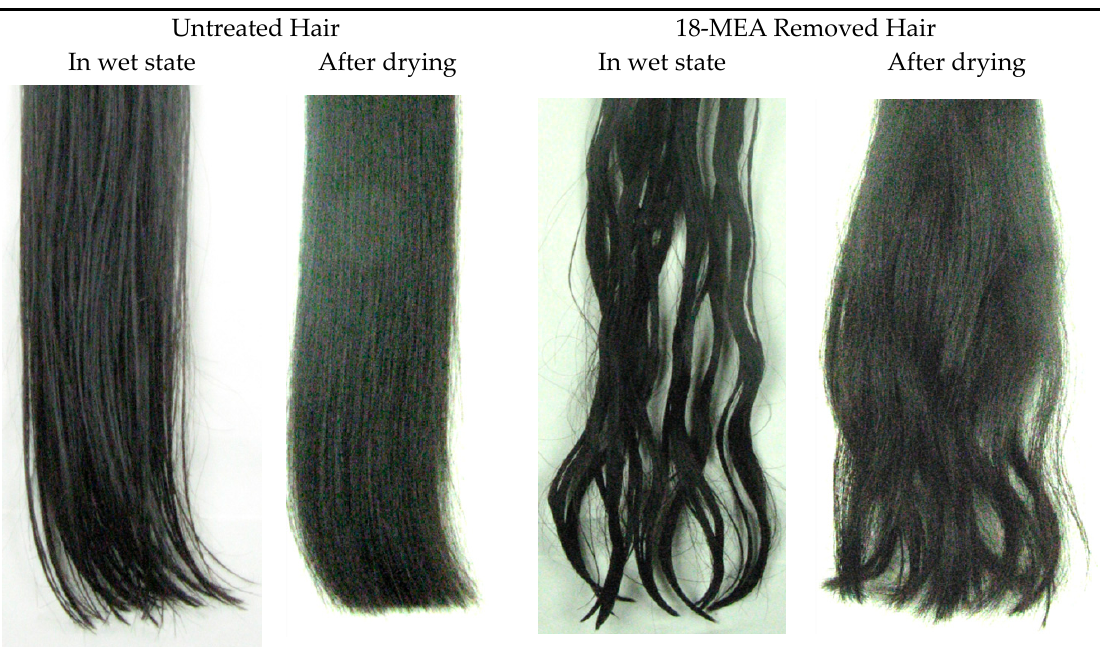
Figure 10. Shape of hair tresses in wet and dry states.